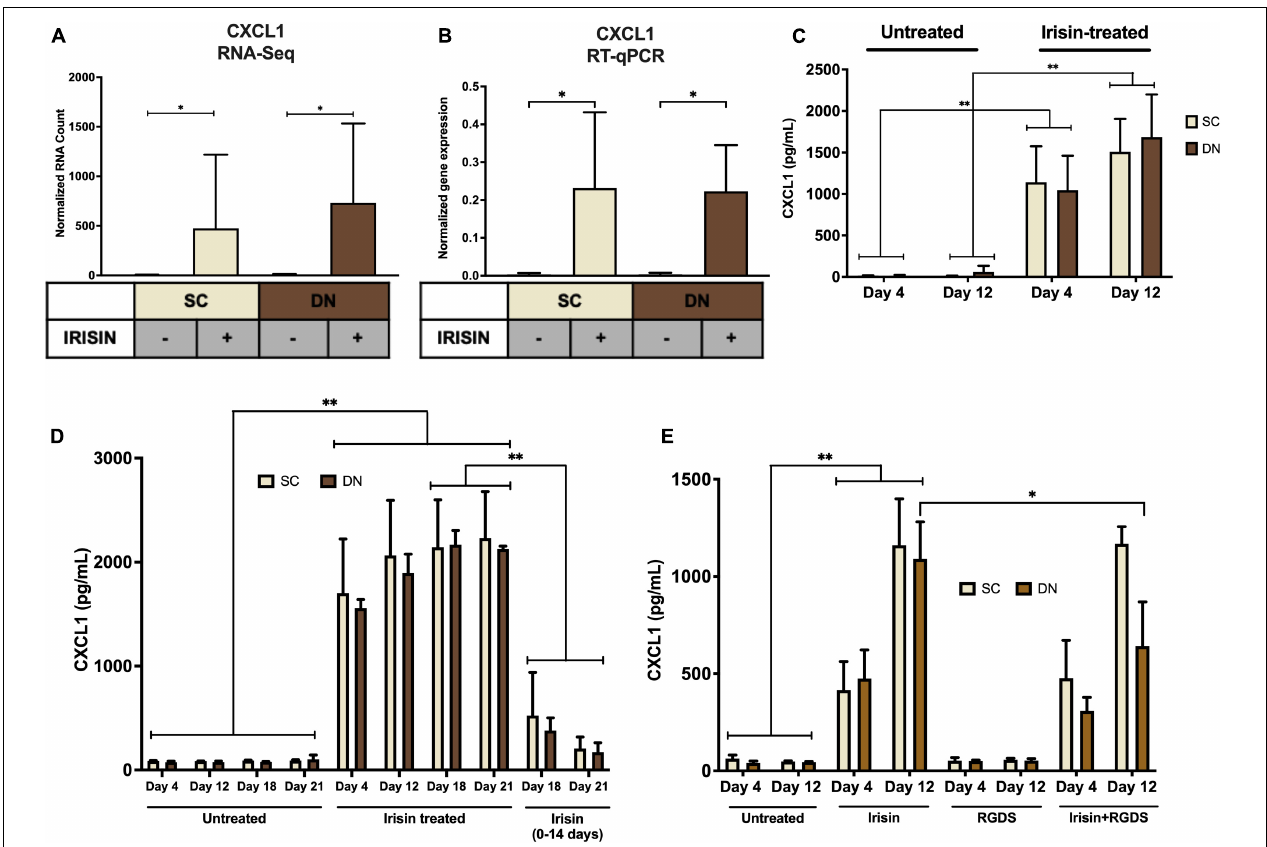
FIGURE 3 | Irisin dependent CXCL1 release was stimulated from differentiating subcutaneous (SC) and deep-neck (DN) area adipocytes. SC and DN preadipocytes were differentiated and treated as in Figures 1 , 2 . Where indicated, irisin was omitted from the differentiation medium at day 14. Conditioned differentiation media was collected and secreted CXCL1 was measured by sandwich ELISA. (A) Quantification of CXCL1 gene expression as determined by RNA Sequencing ( n = 9) or RT-qPCR (B) normalized to GAPDH ( n = 5), (C) CXCL1 release by ex vivo differentiating SC and DN adipocytes into the conditioned media collected at the indicated intervals, in the presence or absence of irisin ( n = 4), (D) CXCL1 release in conditioned medium collected at indicated intervals from untreated (21 days) and irisin treated (14 and 21 days as indicated) cell-culture samples ( n = 3), (E) CXCL1 release from differentiating adipocytes with or without irisin treatment, in the presence or absence of 10 µ g/ml RGDS ( n = 4). Comparisons are for the respective days in case of ELISA. Data presented as Mean ± SD. ∗ p < 0.05, ∗∗ p < 0.01. Statistics: GLM (A) , One-way ANOVA with Tukey’s post-test (B) , Two-way ANOVA with Tukey’s post-test (C–E) .